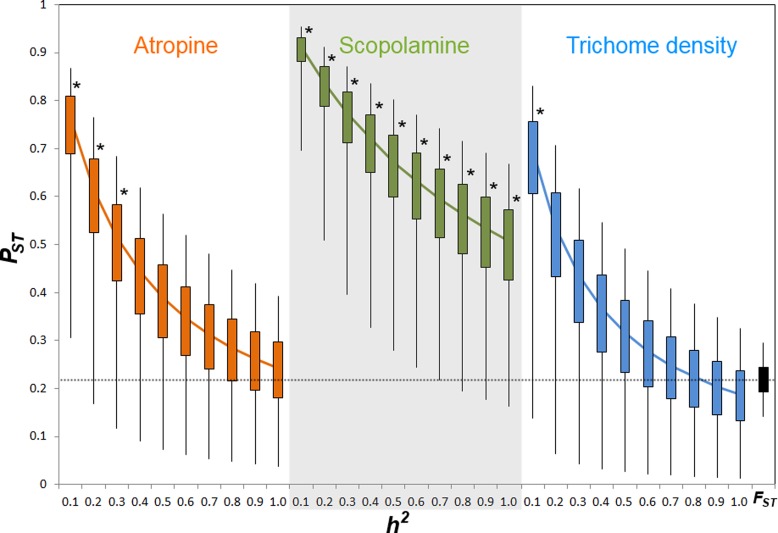
PST values of putative defensive traits of Datura stramonium as a function of their genetic variance (h2) among populations.Confidence intervals of 50% and 95% are indicated by bars and lines, respectively. * Represents overall PST values that differ significantly from FST (the black bar at the right end) after a Monte Carlo test (10,000 deviates from both PST and FST; see ‘Methods’).